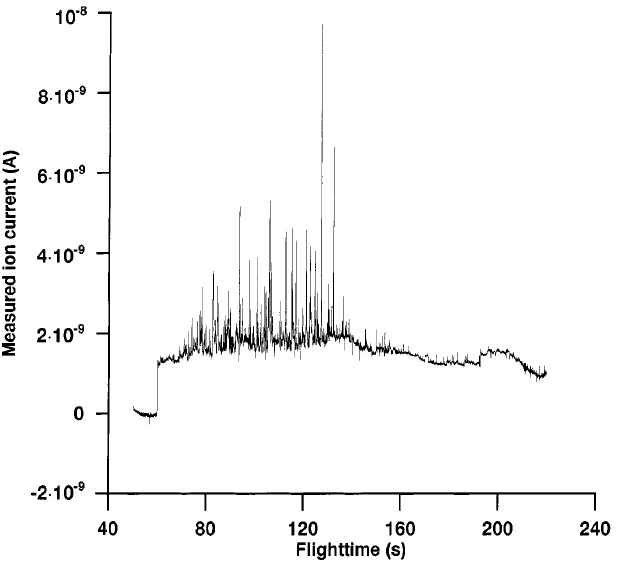
Fig. 4. An example of the detailed structure of the current enhance- ments in a selected time of flight